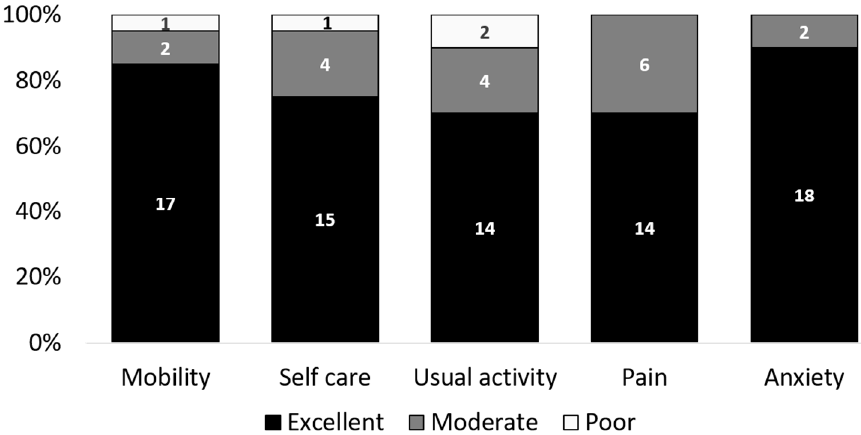
Figure 5. Subdimension of EQ-5D. Categories differ between excellent, moderate, and poor results. The bars represent 100% of the included cases ( n = 20).